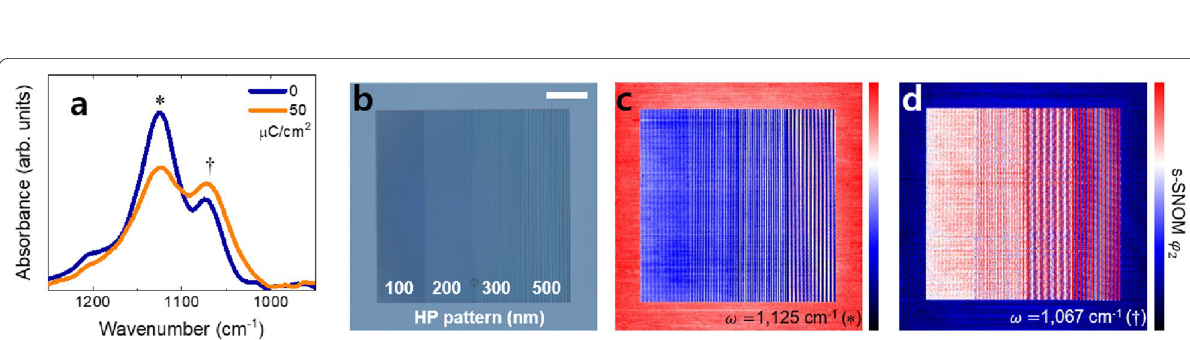
Fig. 3 a FTIR spectra of as‑cast (0 μC/cm 2 ) and e‑beam‑exposed (50 μC/cm 2 ) HSQ films for the range of Si–O–Si vibration. b Optical microscope image of e‑beam patterned and developed HSQ. 100, 200, 300, and 500 nm periods with 1:1 line and space patterns can be seen. The imaging results of the s‑SNOM phase ( ϕ 2 ) correspond to specific chemical structures. Images were taken at c 1125 cm − 1 and d 1067 cm − 1 , and these respectively represent the cage‑like and network structure. The red color indicates higher infrared absorption. The scale bar is 10